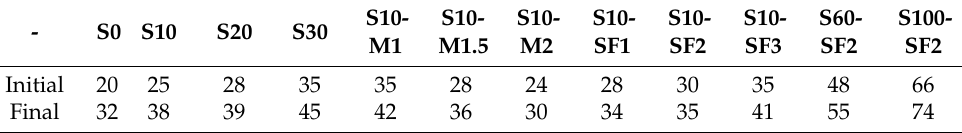
Table 9. Setting times of samples